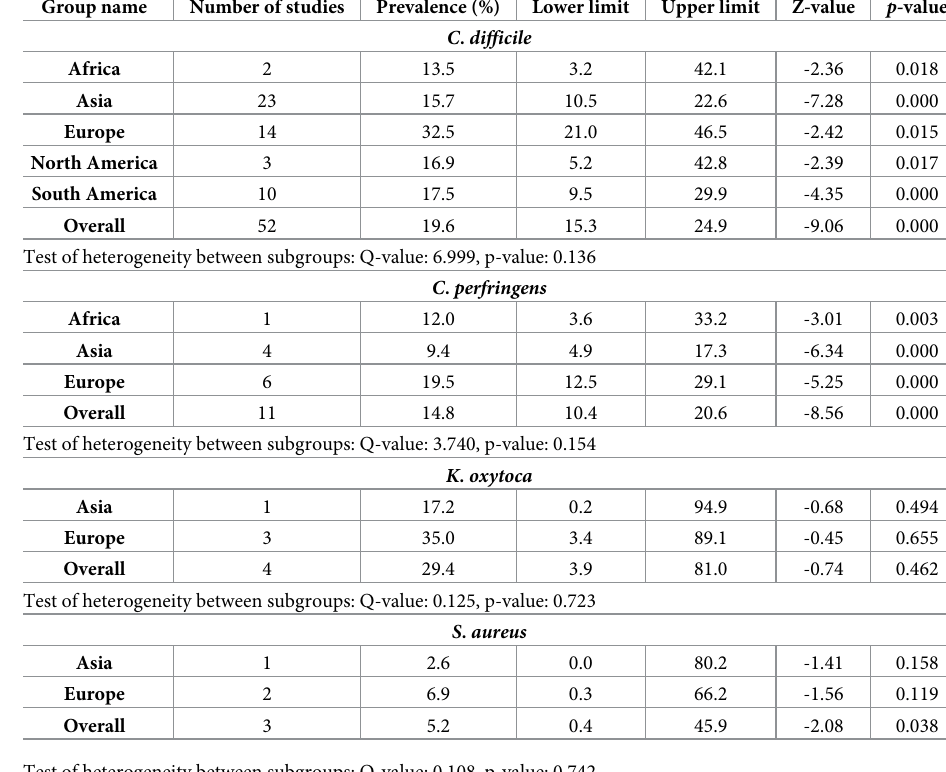
Table 3. Subgroup analysis of bacterial prevalence in AAD patients based on the continents. Group name